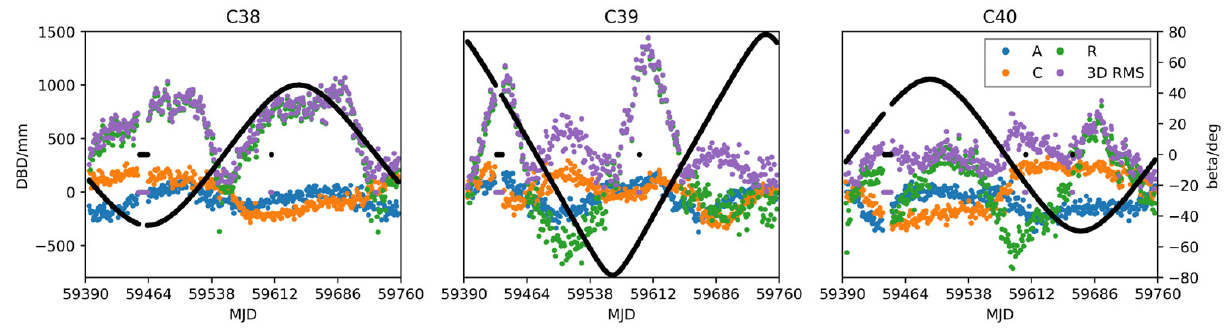
Figure 11. The IGSO orbit DBD time series of the CSNO Scheme in the along-track (A), cross-track (C), radial (R), and 3D RMS.